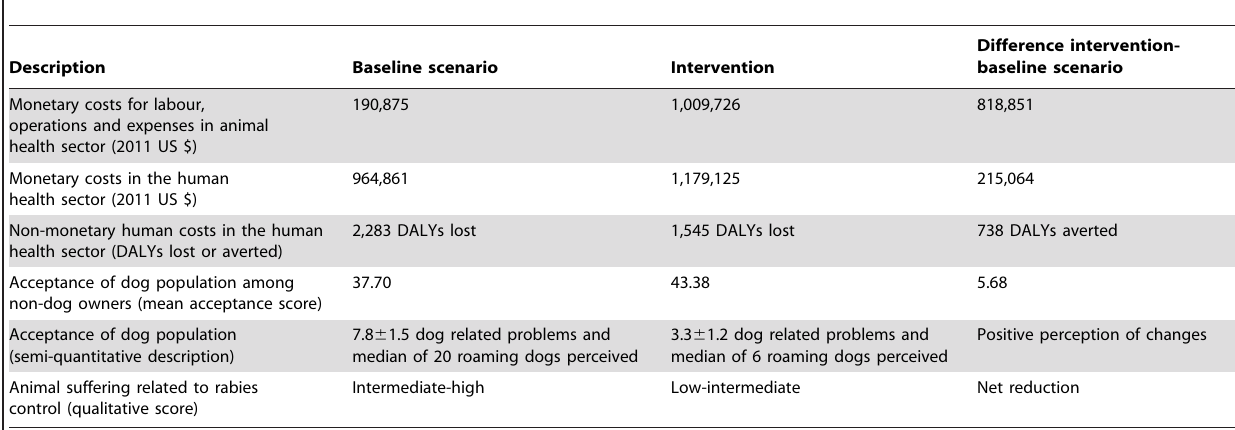
DALYs=Disability Adjusted Life Years.